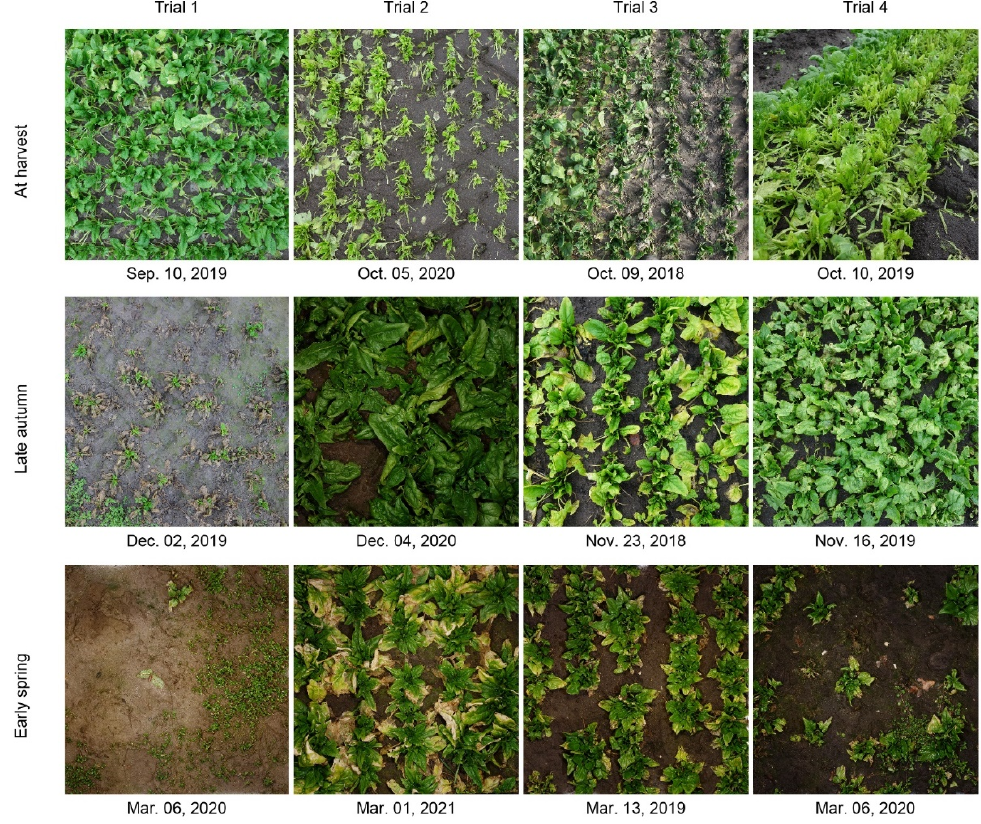
Figure 7. Spinach crop residues in treatment 7 depending on the season and trial. Besides the growth of the catch crops and resprouting spinach crop residues, the disease severity index of spinach based on soil samples taken at the end of experiments 1, 2, and 4 was also calculated (Table 4). However, based on visual evaluations, no differences between the treatments was observed. Spinach seemed to be more affected by the individual site than by the previous tillage treatment. Table 4. Disease severity index of spinach seedlings at the end of the trials ( n = 4; Mean ± SD)